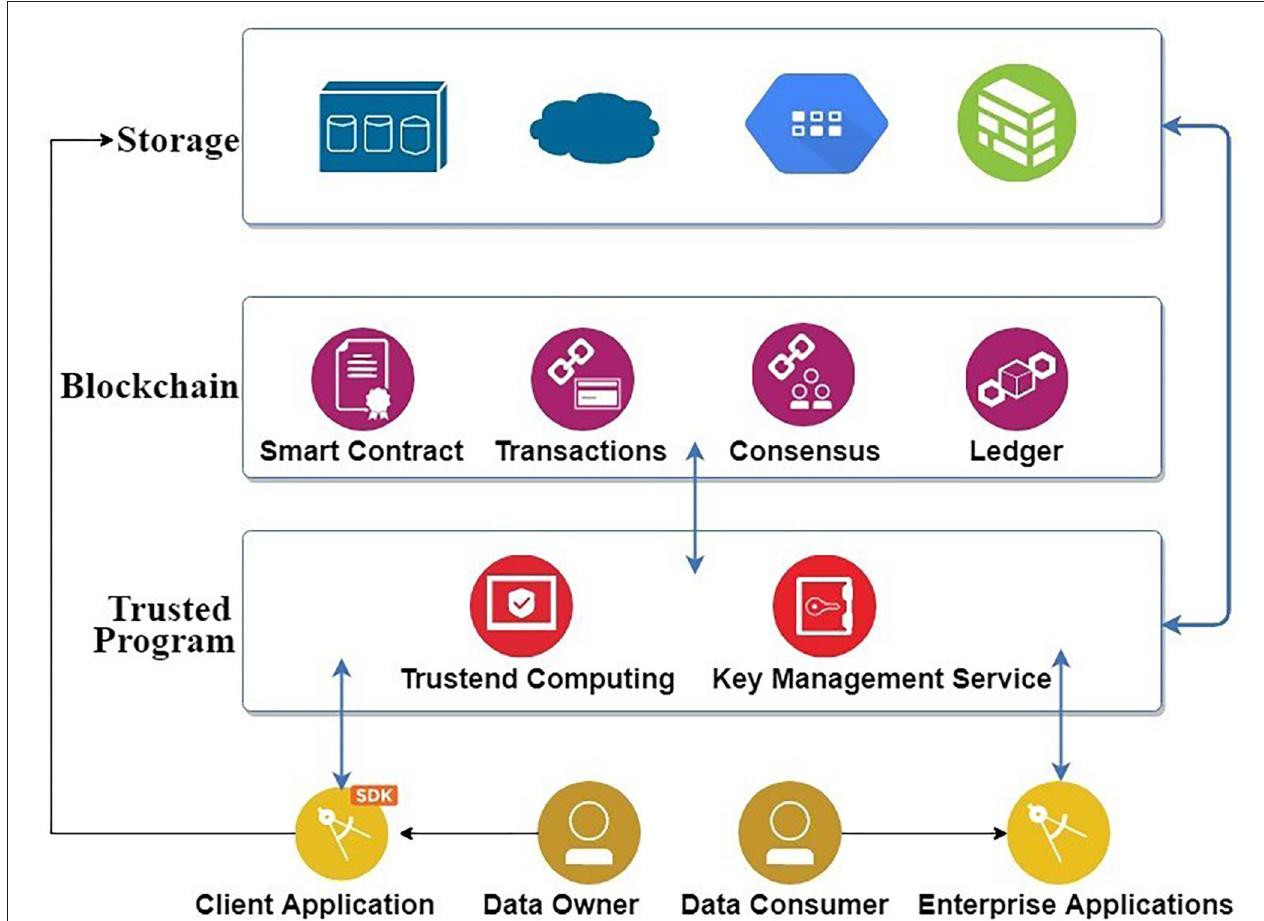
FIGURE 1 | User-controlled privacy-preserving data sharing